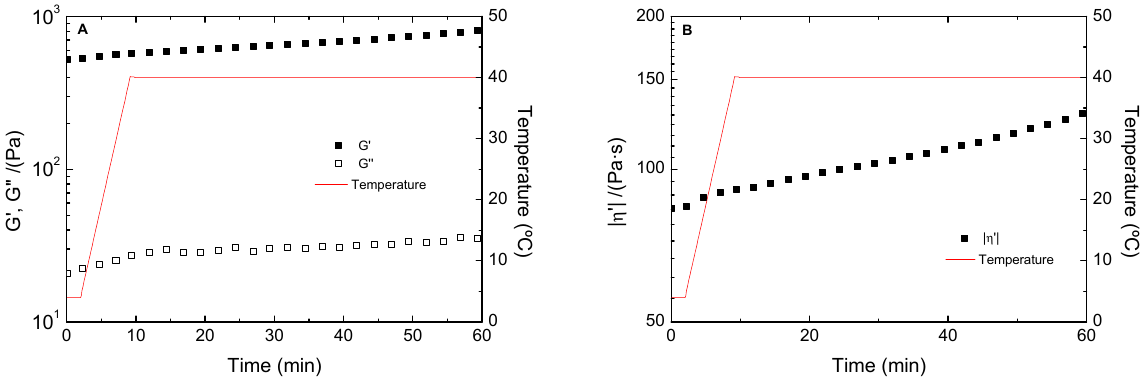
Figure 7. Temperature ramp tests of chitosan hydrogels processed at 4 °C and 1.5 wt.% chitosan. The presented data are the mean values for each system. ( A ) Elastic (G’) and viscous (G’’) moduli profile. ( B ) Complex viscosity profile.